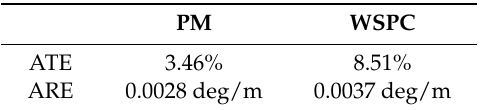
Figure 6. The feature points tracking results in scenario 2. ( a ) Frame 69; ( b ) Frame 70; ( c ) Frame 79; ( d ) Frame 89. Table 3. Number of the green points and proportion of the inliers. Frame 69